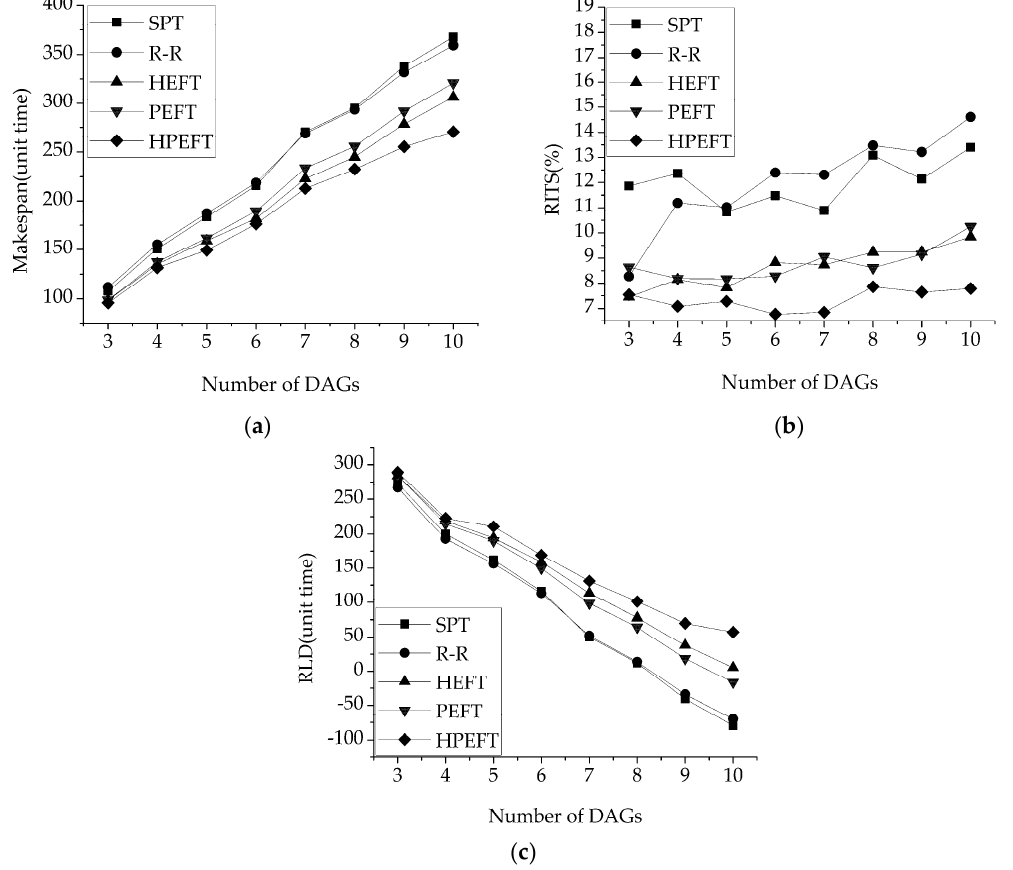
Figure 9. Variable number of DAGs: ( a ) makespan, ( b ) RITS, and ( c ) RLD.